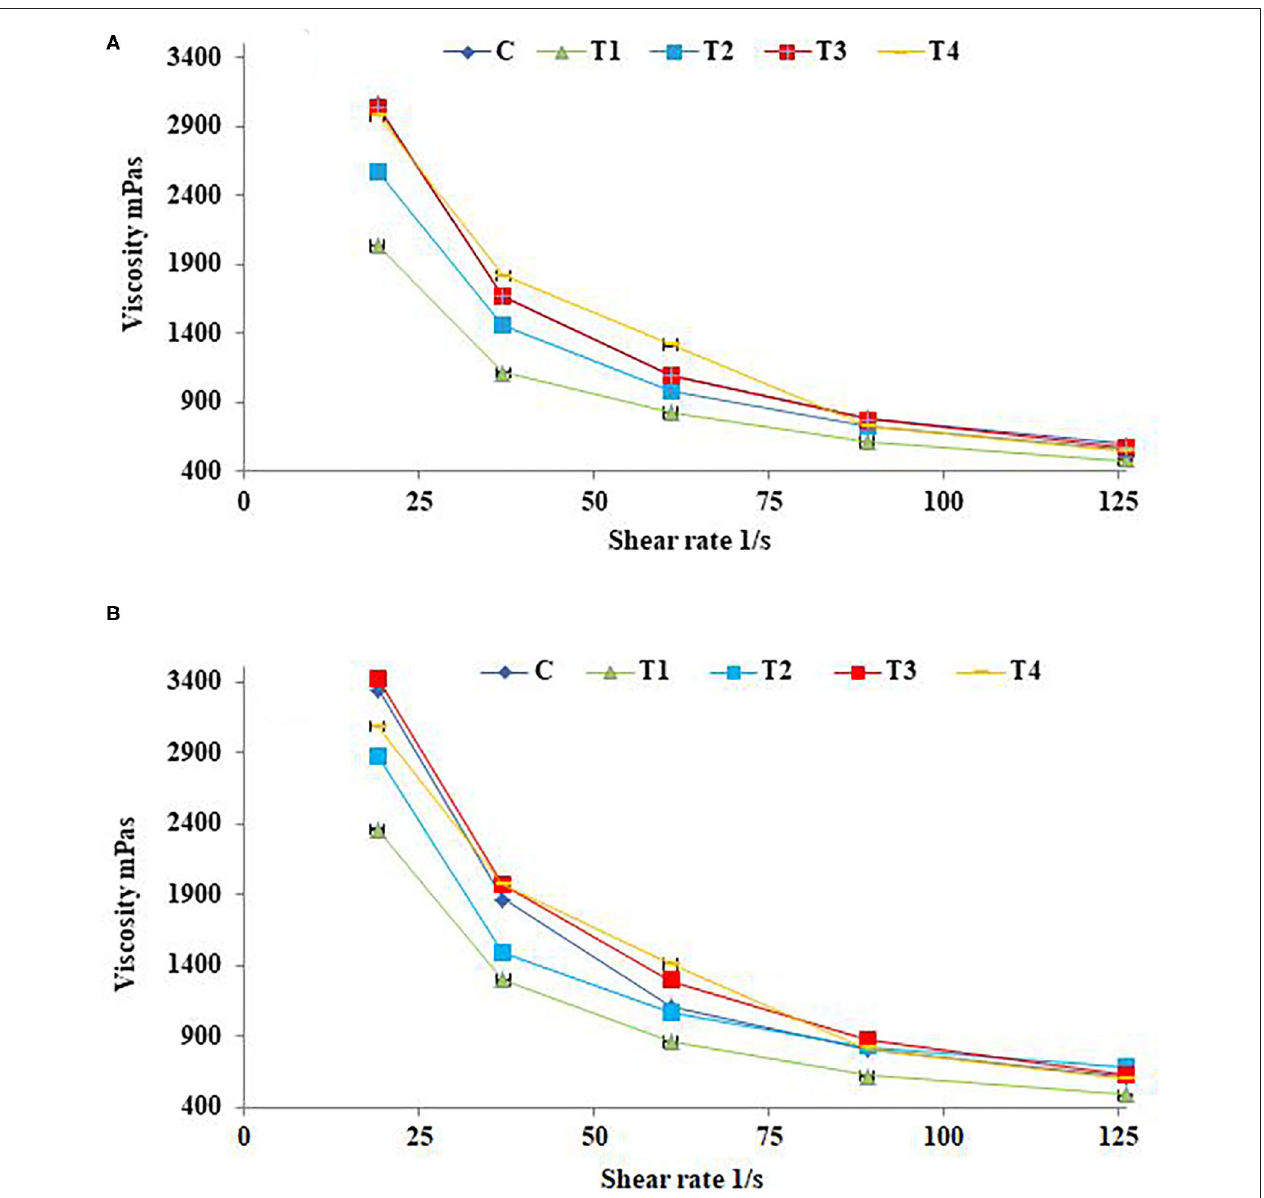
FIGURE 2 | Apparent viscosity of stirred functional yogurt products at different shearing rates. (A) Fresh products. (B) After 21 days of cold storage. Data represented as means of duplicates ± SD. C, Control plain SFY; T 1 , SFY fortified with free Fe + ascorbic acid; T 2 , SFY fortified with free Fe + FA + ascorbic acid; T 3 , SFY fortified with Fe@BSA-NPs + ascorbic acid; T 4 , SFY fortified with Fe + FA @BSA-NPs + ascorbic acid. BSA-NPs, Bovine Serum Albumin nanoparticles; FA, Folic